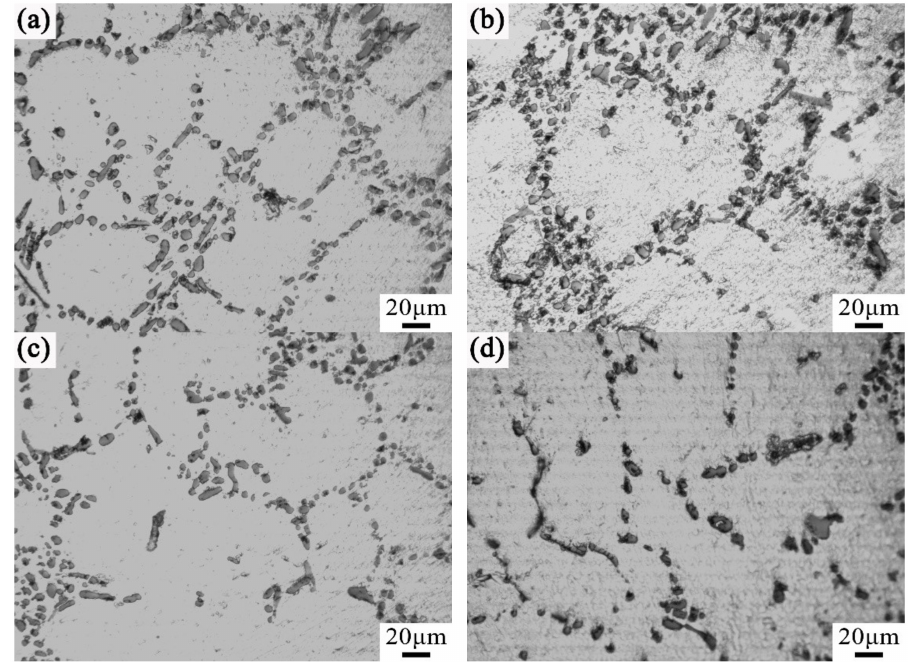
Figure 6. The microstructure of the Al-7Si-0.55Mg alloy with di ff erent pulse currents at a pulse frequency of 40 Hz: ( a ) 300 A, ( b ) 600 A, ( c ) 900 A and ( d ) 1200